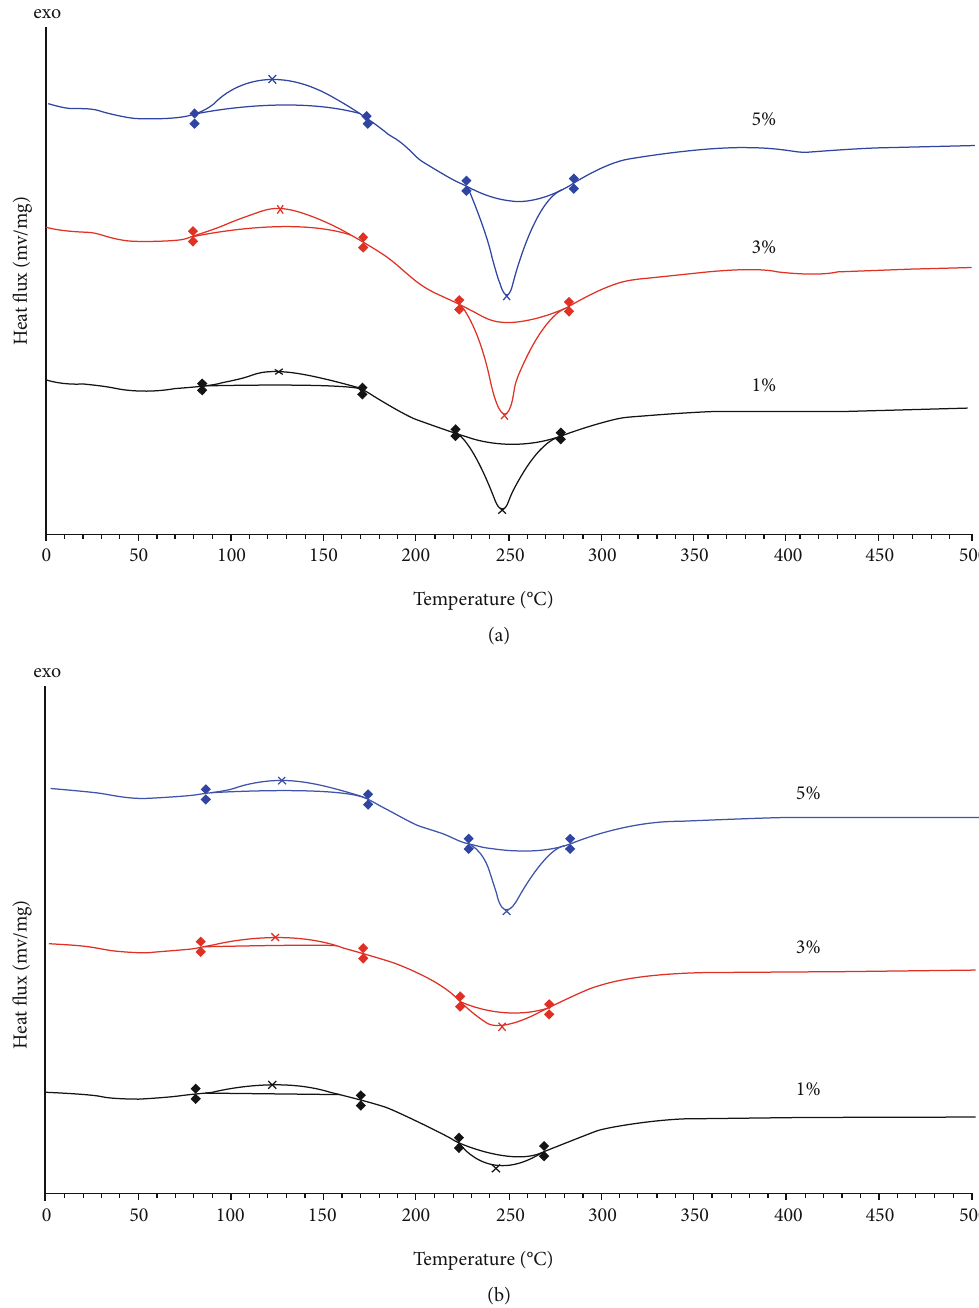
Figure 6: DSC thermograms of polyethylene fi lms containing 1, 3, and 5%: (a) leaf extract; b) gum